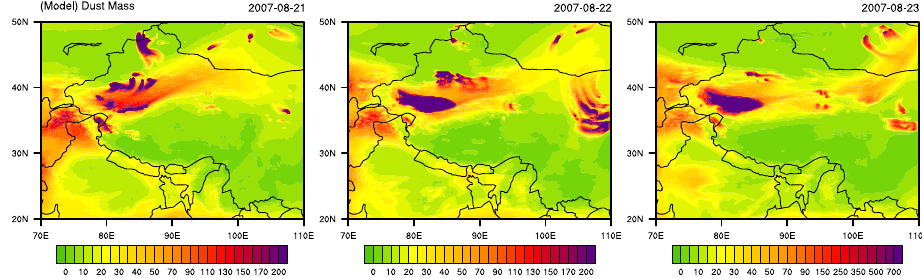
Figure 9. Distributions of the simulated dust mass column loading (units: mgm − 2 ) from 21 to 23 August 2007.